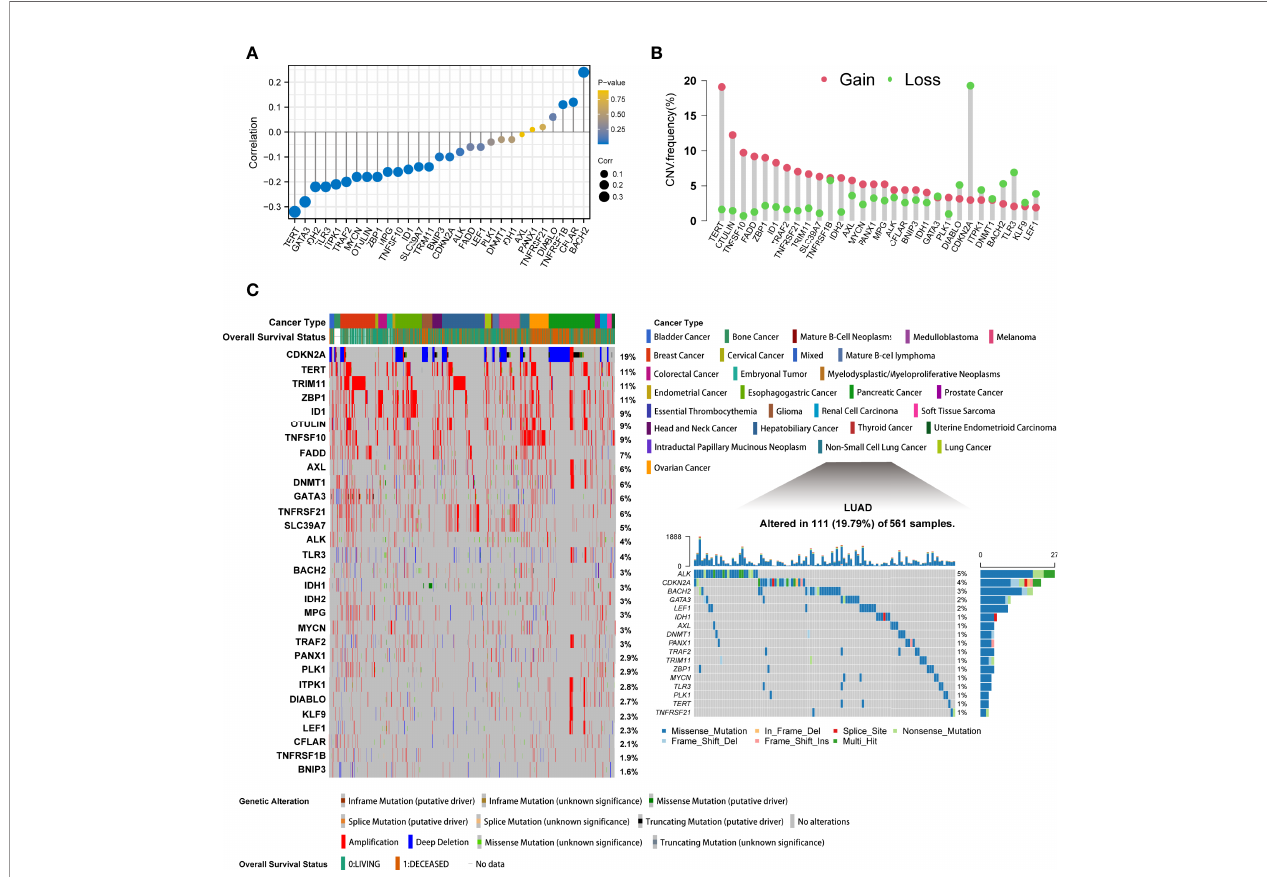
FIGURE 1 | The epigenetic alteration landscape of necroptosis molecules in lung adenocarcinoma. (A) The lollipop chart showed the correlations between DNA promoter methylation and mRNA expression levels. The circle size represented the correlation coef fi cients. Bluer dots indicated a lower p-value. (B) The CNV frequency of necroptosis regulators in TCGA cohort. The height of bars represented the alteration frequency. Pink represented CNV ampli fi cations (gain), and green dot represented CNV deletions (loss). (C) The left part showed the mutant frequency and types in 28 cancers from cBioPortal. Each column indicated individual patients. The upper band showed cancer types and vital status. The number on the right displayed the mutation frequency of each gene. The right part illustrated the somatic genetic mutation landscape in lung adenocarcinoma in TCGA. The upper barplot showed the overall mutation frequency of each sample. The right stacked barplot demonstrated the proportion of each variant type. Only molecules having mutations, namely mutant frequency > 0%, were illustrated in the waterfall